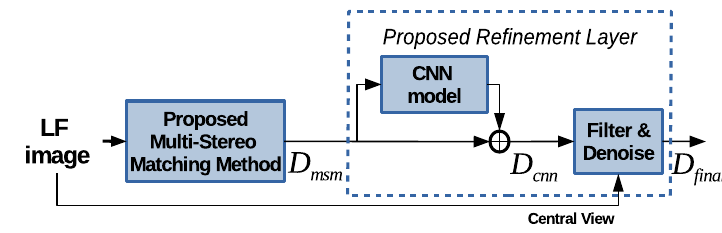
Figure 1. The scheme of the proposed depth-estimation method based on stereo matching and